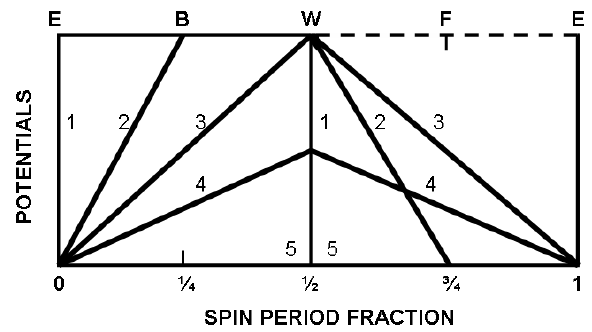
Fig. 2. Hypothetical linear charging voltages as functions of the spin period fractional times. The charging rate on the dark side is assumed to be equal to the discharge rate on the sunlit side. The horizontal dashed line represents the dark side equilibrium value. The top letters denote the east (E), back (B), west (W), and front (F) surfaces relative to the sun